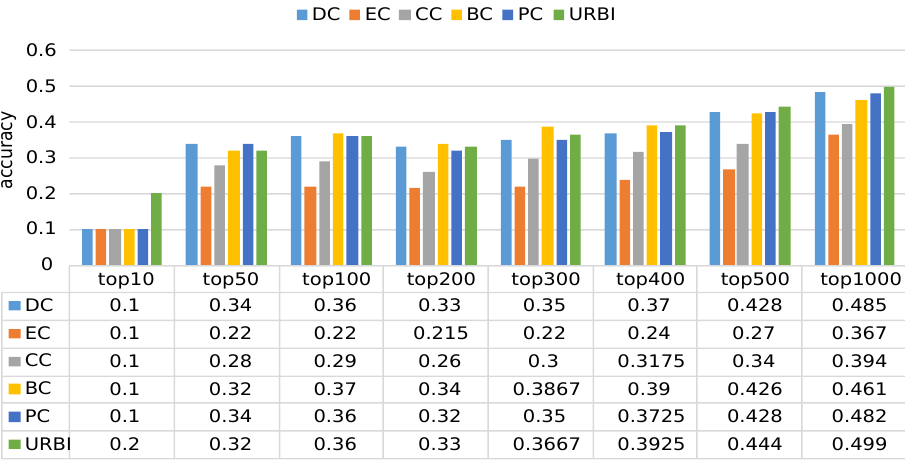
Figure 8. This figure depicts the experimental results of dataset No.8, which contains 8102 book nodes.